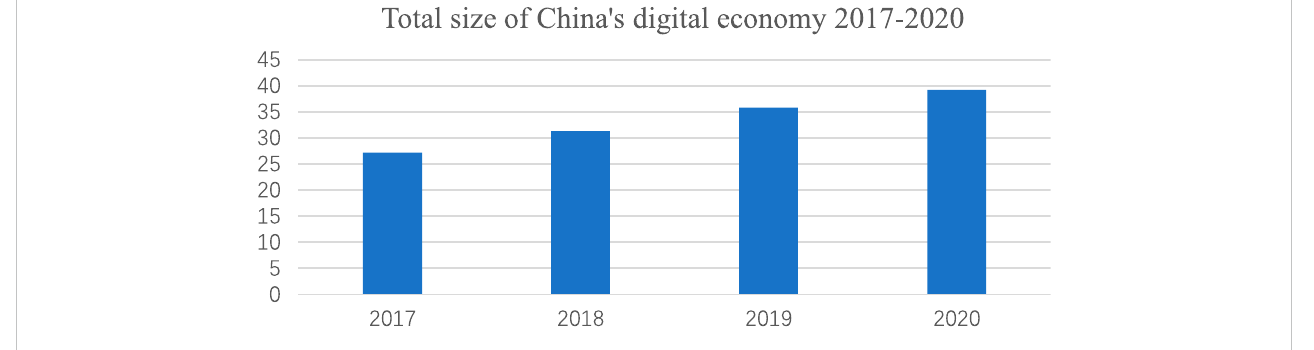
FIGURE 3 Total size of China ’ s digital economy 2017 – 2020 (data source: China Academy of Information and Communications Technology and China Business Industry Research